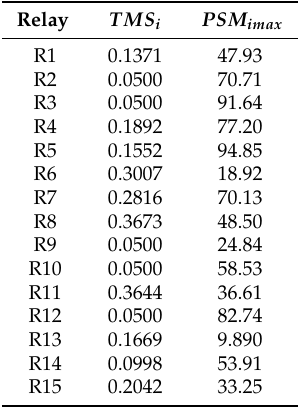
Table 11. Coordination parameters considering all OMs.